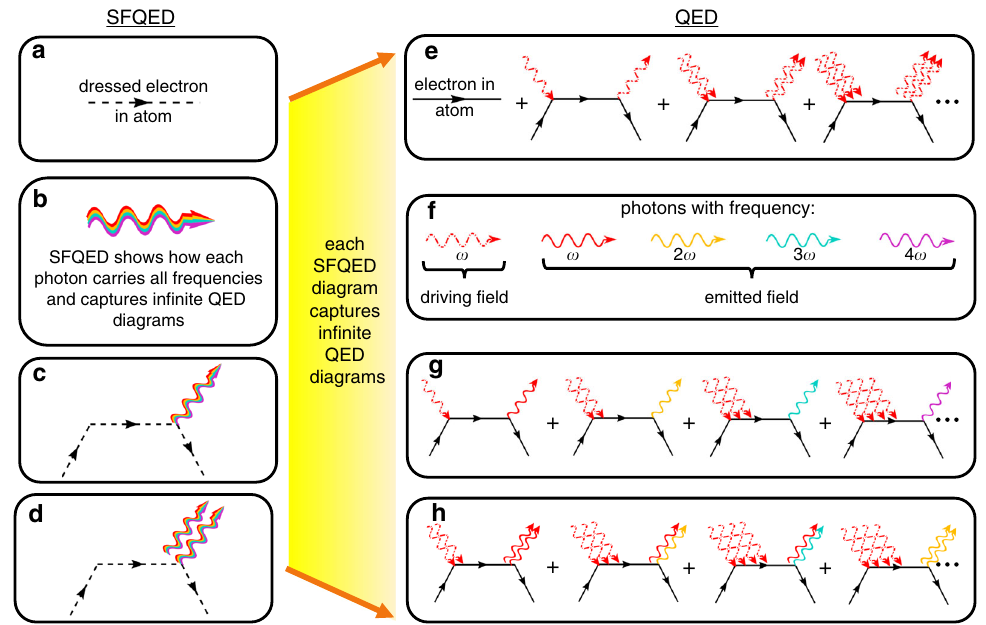
Fig. 1 Diagrams in strong- fi eld quantum electrodynamics (SFQED) versus ordinary quantum electrodynamics (QED). In SFQED ( a – d ), we have perturbation theory in the weak emitted fi eld: c , d correspond to different numbers of emitted photons. Each perturbation order in SFQED is equivalent to in fi nite diagrams of emission and absorption processes in the standard formulation of QED ( e – h ); a , b corresponds to zero-order SFQED, containing all the QED diagrams e , f necessary to describe the evolution of the wavefunction according to the time-dependent Schrodinger equation (Eq. 2); c corresponds to fi rst-order SFQED (equivalent to g in QED), which we use to capture the effect of high harmonic generation; d corresponds to second-order SFQED (equivalent to h in QED), which can capture new processes in extreme nonlinear optics, such as laser-driven two-photon spontaneous and ε 0 is the vacuum permittivity. A q and A c describe the quantum emitted fi eld and the classical driving fi eld, respectively.